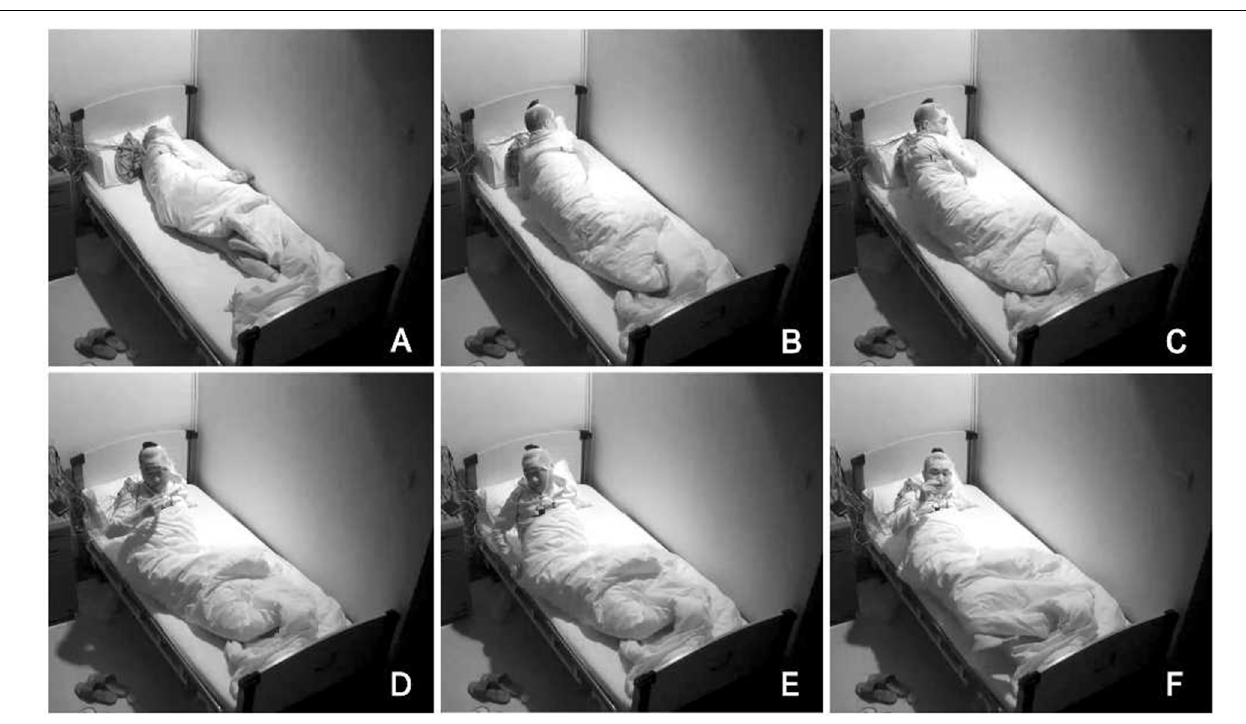
of information processing. The other function of arousals is tailoring the more or less stereotyped endogenously determined sleep process driven by chemical influences according to